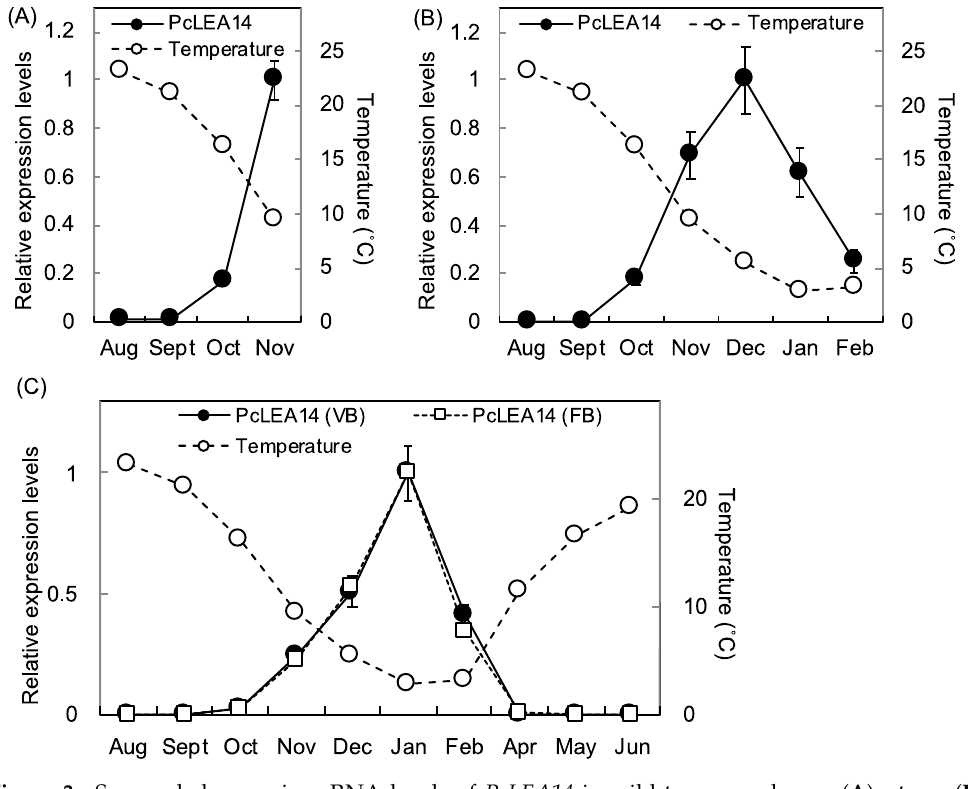
Figure 3. Seasonal changes in mRNA levels of PcLEA14 in wild-type pear leaves ( A ), stems ( B ), and buds ( C ) at air temperature: each value was determined from three independent biological replicates. Data show the relative expression levels normalized against PcActin for leaves and stems and PcGAPDH for buds. Values indicate the means ± standard error ( n = 3). VB and FB indicate vegetative buds and flower buds, respectively ( C ).